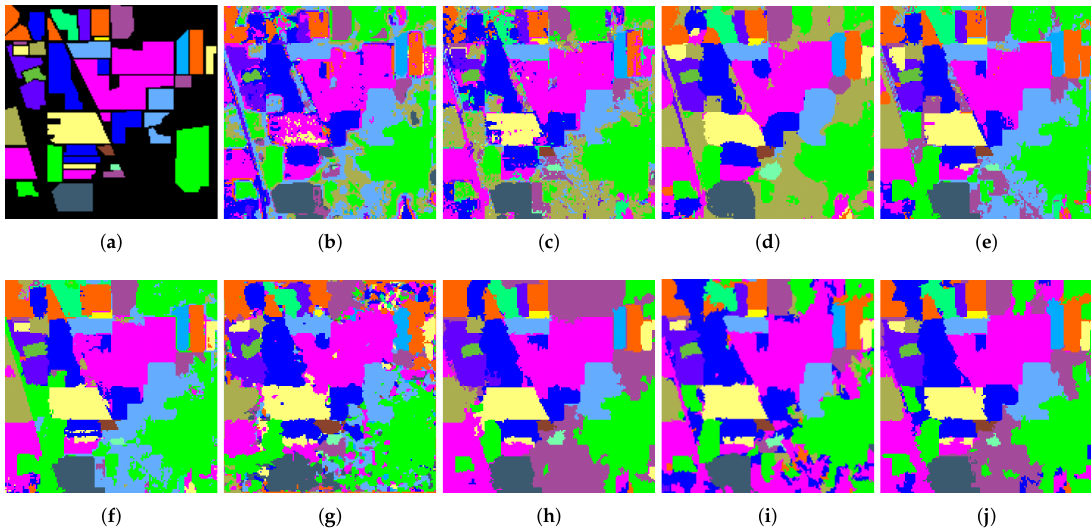
Figure 2. Classification results of Indian Pines (IP) with about 2.7% training samples per class. ( a ) Ground-truth; ( b ) SVM-CK; ( c ) SpMK; ( d ) ANSSK; ( e ) RMK; ( f ) EMAP; ( g ) invariant attribute profile (AIP); ( h ) ASMSSK; ( i ) LRCISSK; ( j ) MASEMAP-